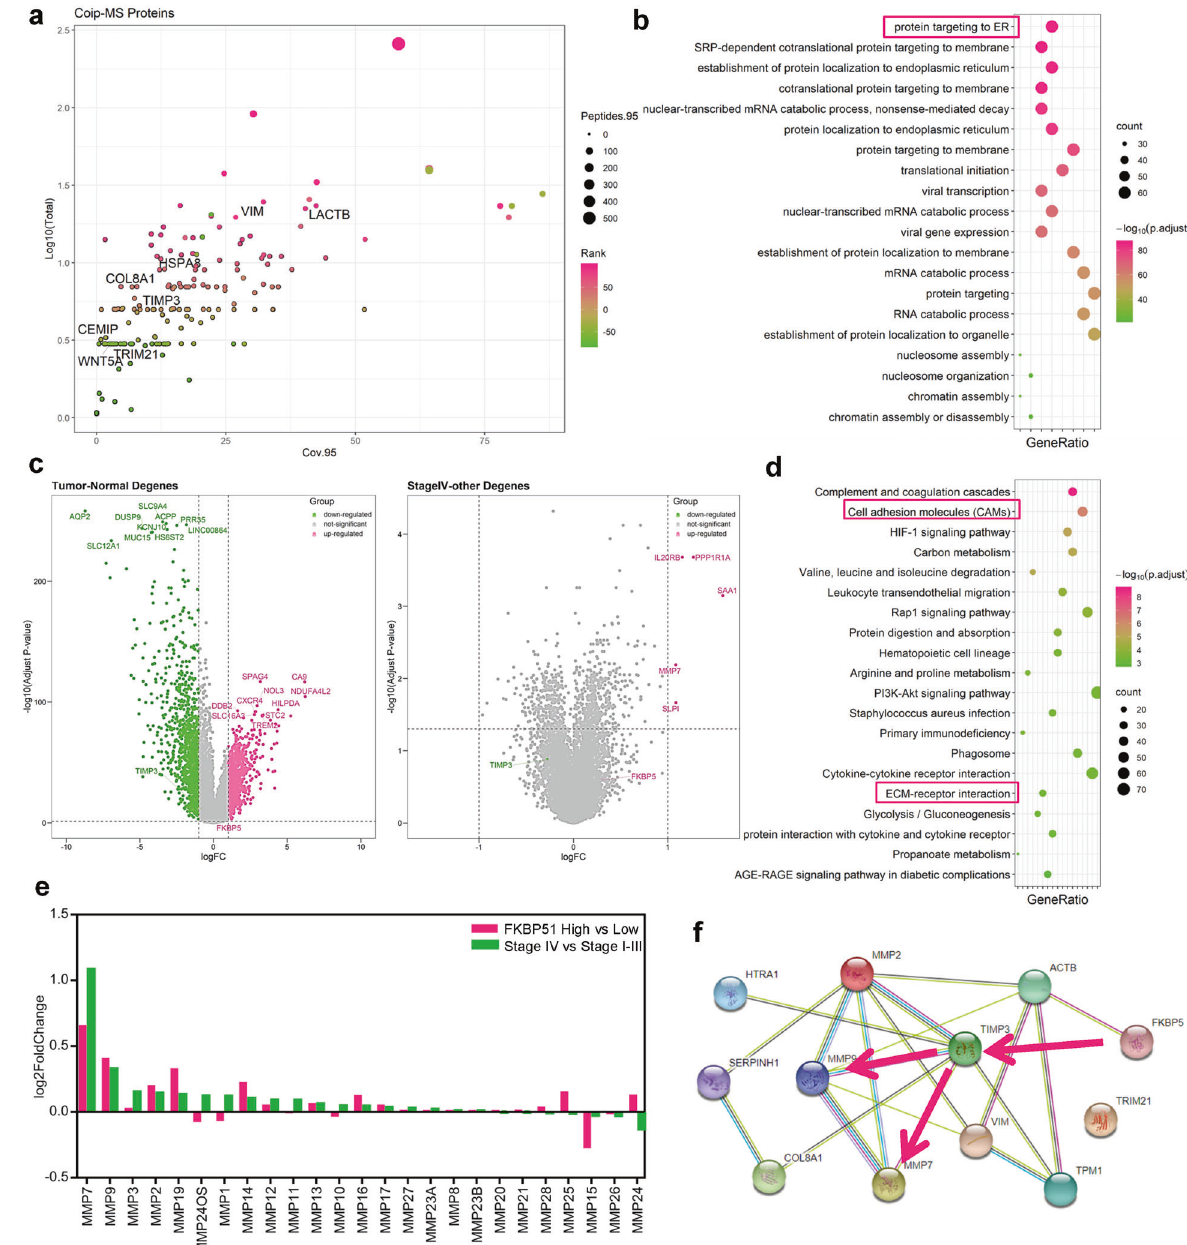
Fig. 3 Bioinformatic analysis of Co-IP – MS data and RNA-Seq data from TCGA. a Scatter plot showing the 257 proteins identi fi ed by Co- IP – MS. b Dot plot showing the biological processes, cellular components, and molecular functions in which the 257 proteins from Co-IP – MS analysis were enriched by GO enrichment analysis. c Volcano plot showing the differentially expressed genes (DEGs) between tumor ( n = 538) and normal ( n = 72) tissues (left panel) and between stage IV ( n = 70) and stage I – III ( n = 377) groups (right panel). d Dot plot showing the KEGG pathway enrichment results for DEGs between the tumor and normal groups. e Bar plot showing the log2-fold changes for members of the MMP protein family in comparison between the FKBP51 high group ( n = 269) and the FKBP51 low group ( n = 269) (divided by the median in the tumor group) and between the stage IV group ( n = 70) and the stage I – III group ( n = 377). f Protein – protein interaction (PPI) network of metastasis-related genes from our analysis using the STRING database. The red line indicates our hypothesis for the regulatory axes in induced by rapamycin (Fig. 6b). By using CHX with or without To verify our hypothesis, we treated FKBP51 overexpressing siRNA-ATG7 in FKBP51 overexpressing 786-O cells, we found that and knockdown 786-O cells with rapamycin, an inducer of the promotion of TIMP3 degradation induced by FKBP51 autophagy, to observe the changes in TIMP3 expression and LC3 overexpression could be blocked by siRNA-ATG7, and the half- B/A turnover. As shown in Fig. 6a, rapamycin ef fi ciently increased life of TIMP3 increased from 8.53 h (si-Control + CHX + FKBP51) the fl ux of autophagy (LC3B/A rate) and decreased the level of to 20.23 h (si-ATG7 + CHX + FKBP51) (Fig. 6c, d). In addition, by TIMP3, while FKBP51 overexpression promoted TIMP3 degrada- using CHX with or without rapamycin in FKBP51 knockdown 786- tion. The knockdown of FKBP51 decreased the degradation of O cells, we found that induction by rapamycin promoted the TIMP3 and showed no remarkable in fl uence on autophagy fl ux